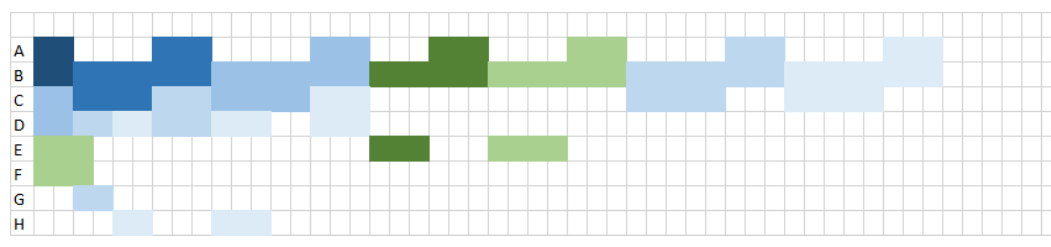
Figure 5. Load-based schedule with MFair .